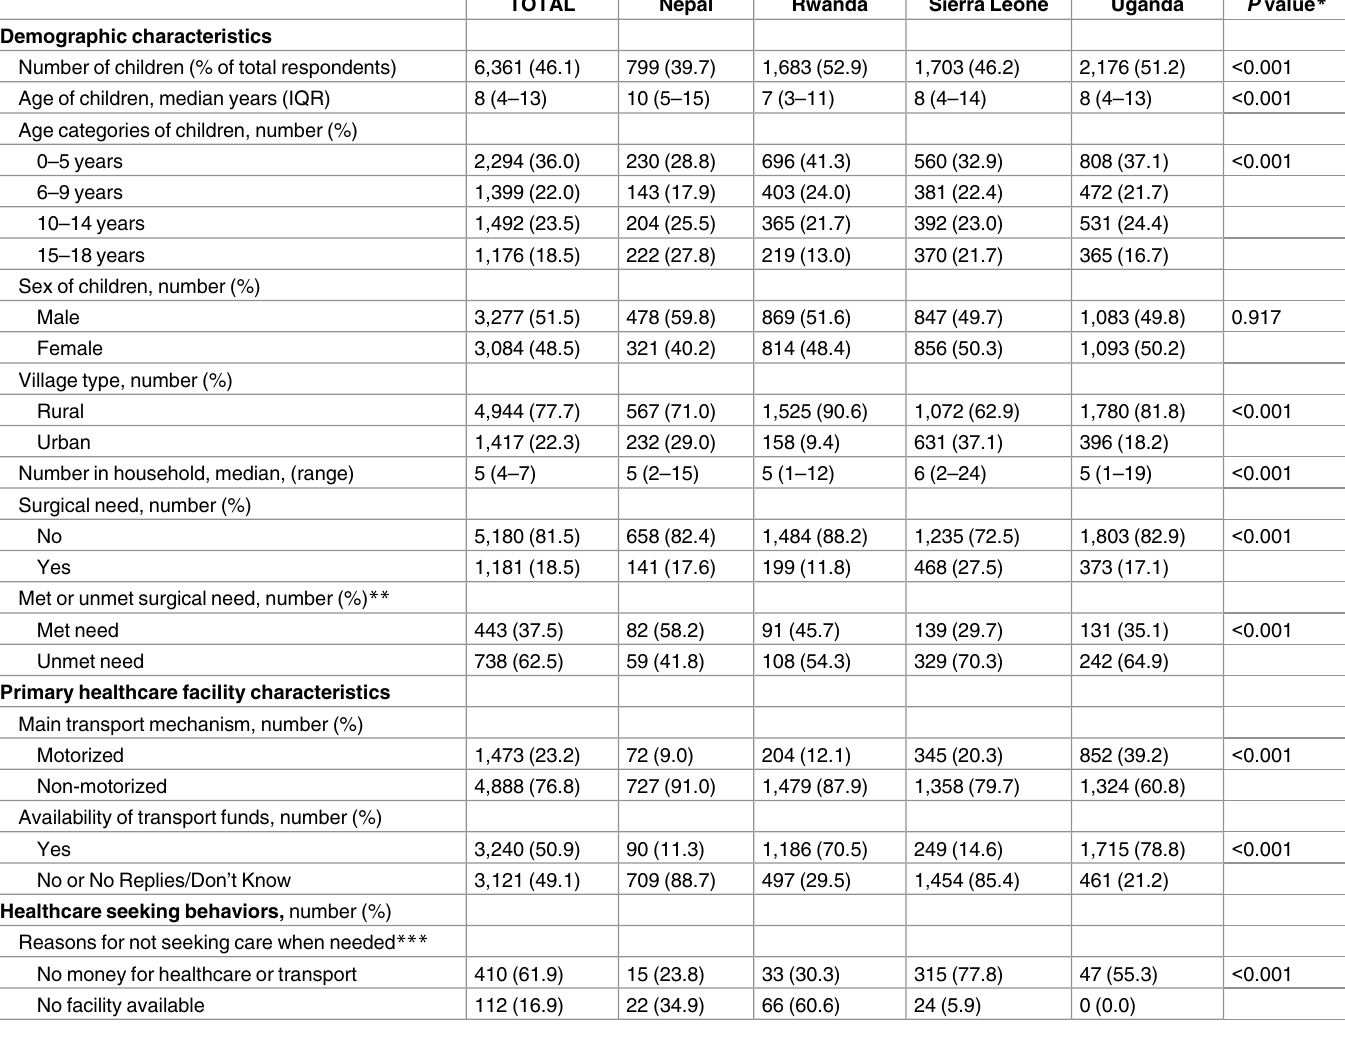
Table 2. Demographic and healthcare facility characteristics and healthcare seeking behaviors among pediatric SOSAS survey respondents, by country. TOTAL